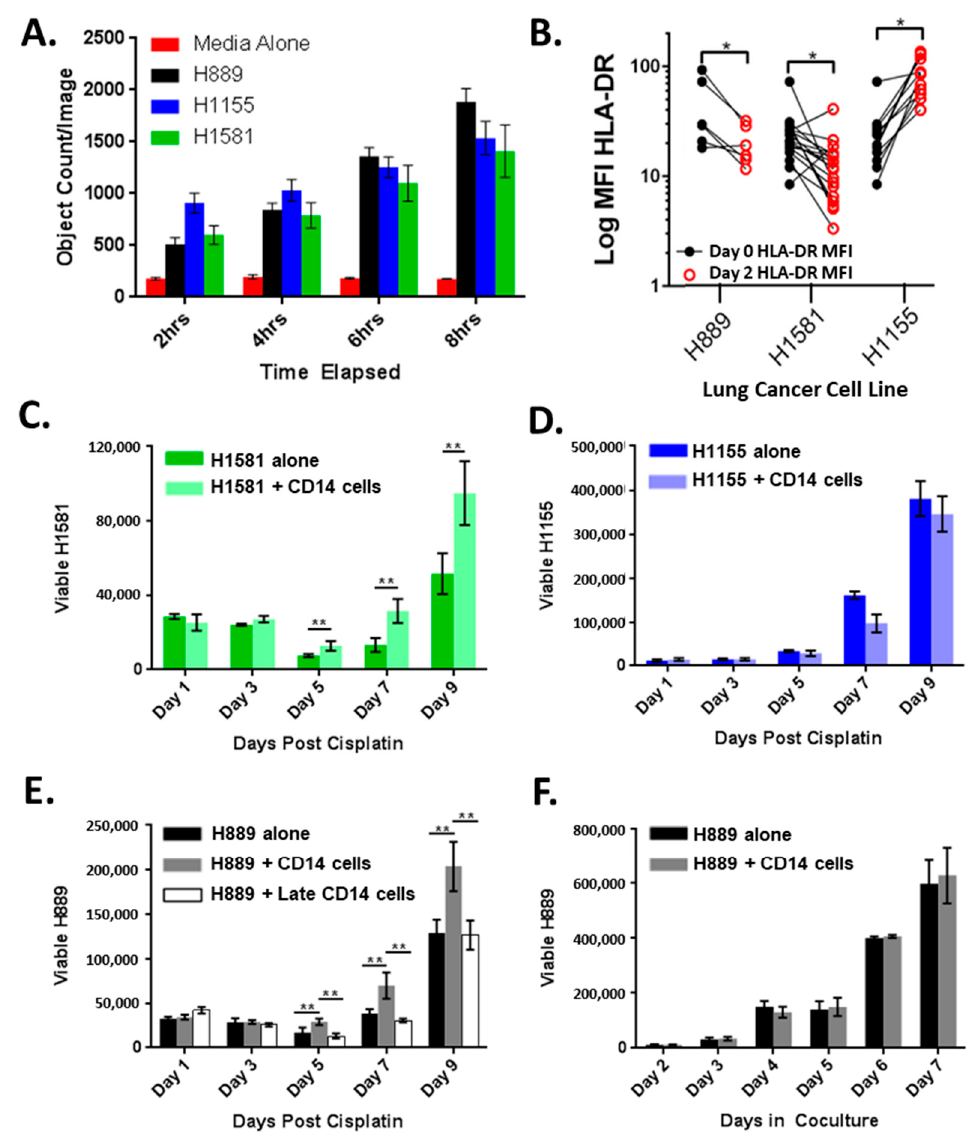
Figure 3. Cross-talk between lung cancer cells and CD14 + cells: ( A ) CD14 + cell migration in response to cell-free tumor supernatants quantified by fluorescent live cell imaging; ( B ) CD14 + cell HLA-DR expression before and after 48 h coculture with lung cancer cell lines. Coculture with CD14 + cells results in improved recovery of ( C ) H1581 but not ( D ) H1155; ( E ) H889 cocultured with CD14 + cells for 48 h results in improved tumor recovery but not if CD14 + cells were added just before chemotherapy (H889 + Late CD14 cells); ( F ) growth of H889 alone or in coculture with CD14 + cells. * p < 0.05, ** p < 0.01 by 2 sided t -test.